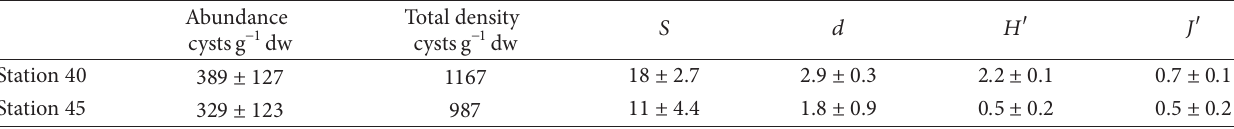
Table 3: Abundance and diversity indices calculated for resting stages in surface sediments at two stations investigated in Bay of